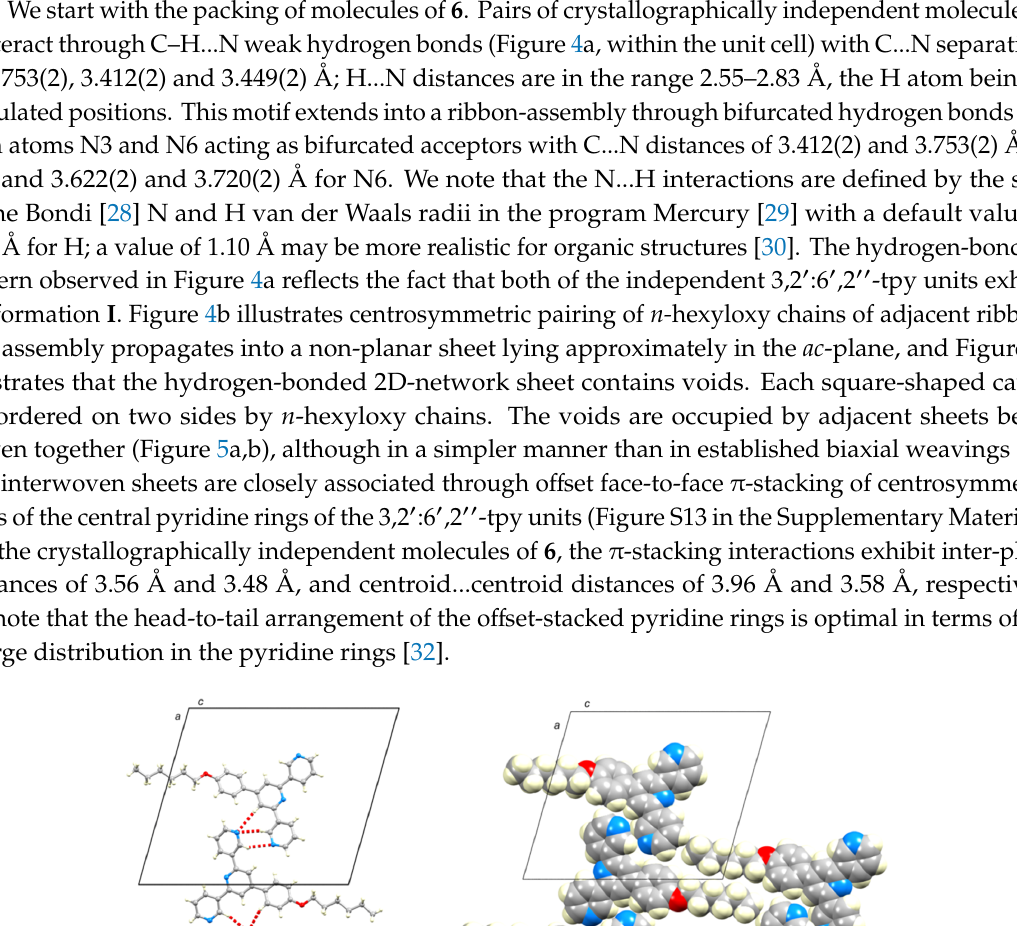
Figure 5. Part of two interwoven supramolecular sheets showing how the voids in one sheet (see Figure 4b) are occupied by n -hexyloxy chains from the next sheet. ( a ) Viewed down the b -axis, and ( b ) viewed approximately down the a -axis. Figure 6a shows that molecules of 7 pack into ribbons with a similar C–H...N weak hydrogen bonding pattern as observed in the solid-state structure of 6 , and the same interwoven supramolecular network assembles (Figure 6b). The interwoven network is supported by offset, face- to-face  -stacking of pairs of crystallographically independent molecules of 7 (inter-plane angle = 7.0°, and centroid...centroid distance = 3.58 Å). The similarity between the packing in 6 and 7 negates the need for further discussion of the packing in 7 .